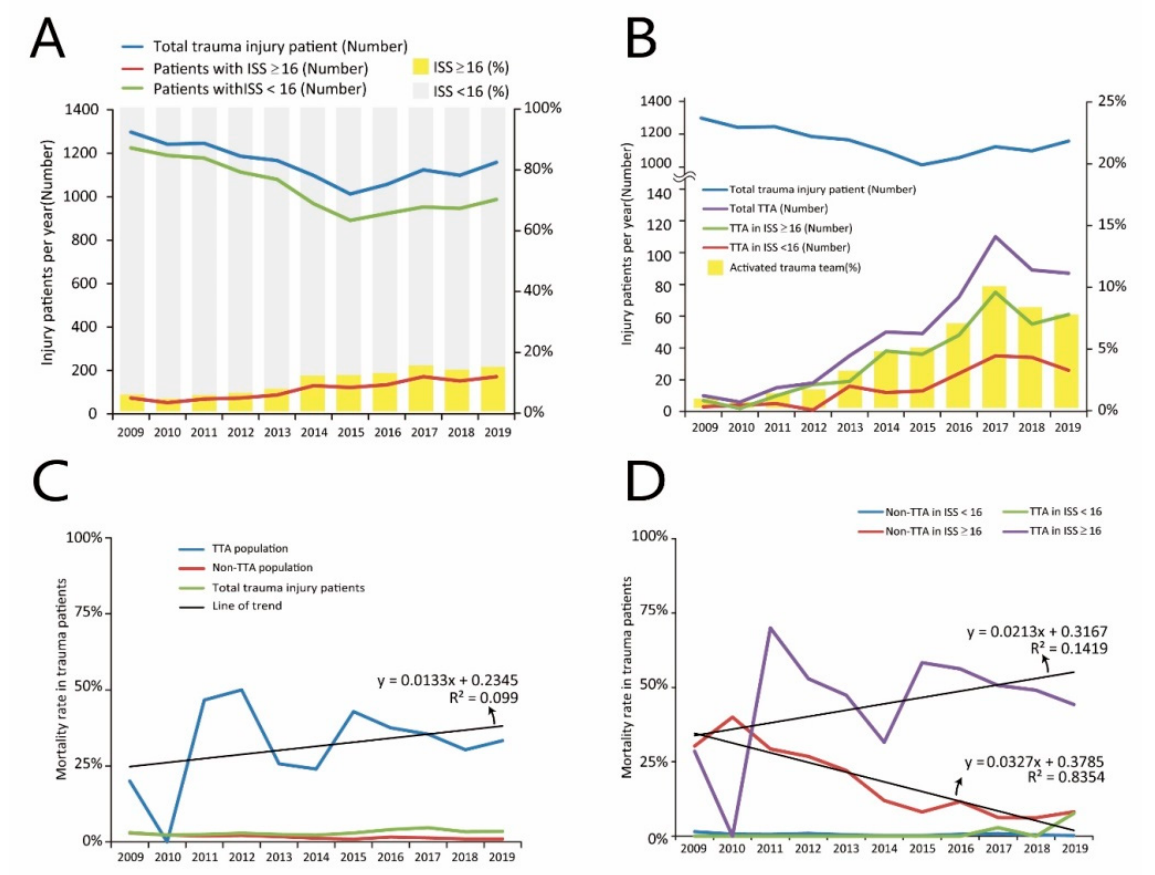
Figure 2. ( A ) Total, minor, and major injury patients number in ten years. ( B ) Trauma team activation with minor and major injury patients number in ten years. ( C ) Annual in-hospital mortality trends in TTA, non-TTA, and total trauma injury population. ( D ) Annual in-hospital mortality trends of TTA and non-TTA in minor and major injury population.